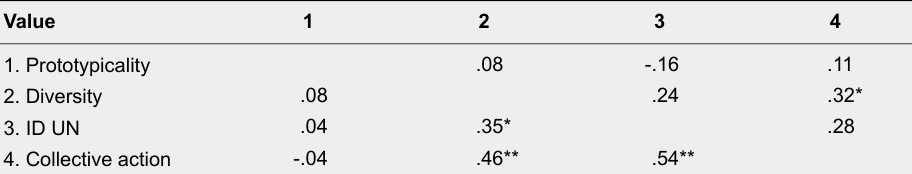
Correlations of Main Variables in the Two Conditions (Measurement Point